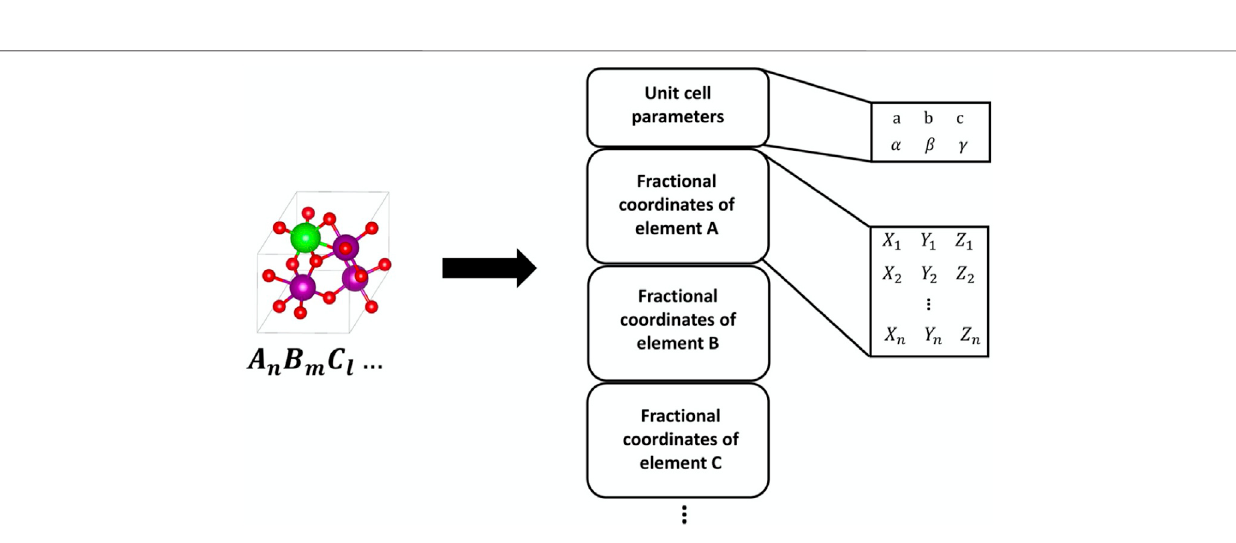
Frontiers in Materials |